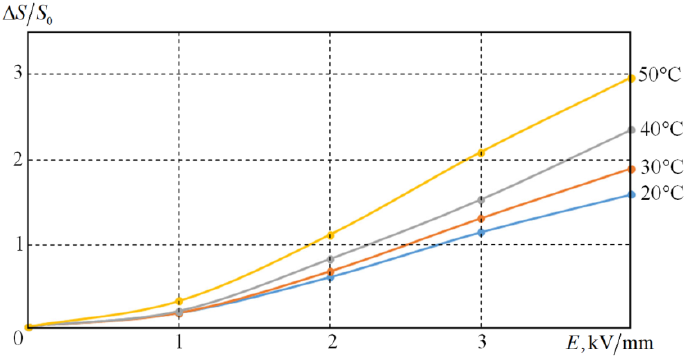
Figure 10. The dependence of ∆ S on the electric field in temperatures 20, 30, 40, and 50 °C.